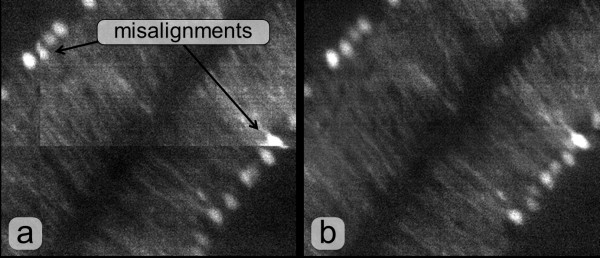
Result of stitching at the border of four overlapping tiles. Merging without aligning nor blending (a) and with aligning and blending (b).